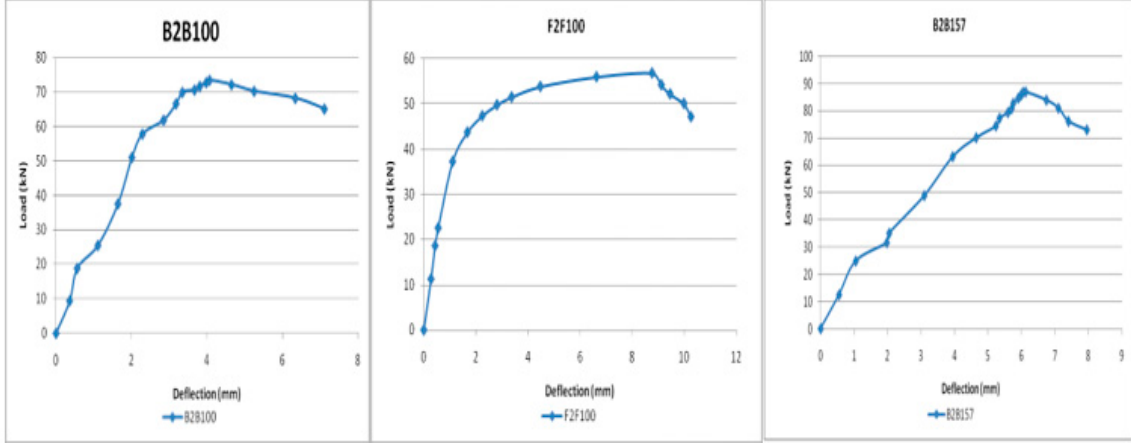
Figure 7. Load vs. deflection behavior.